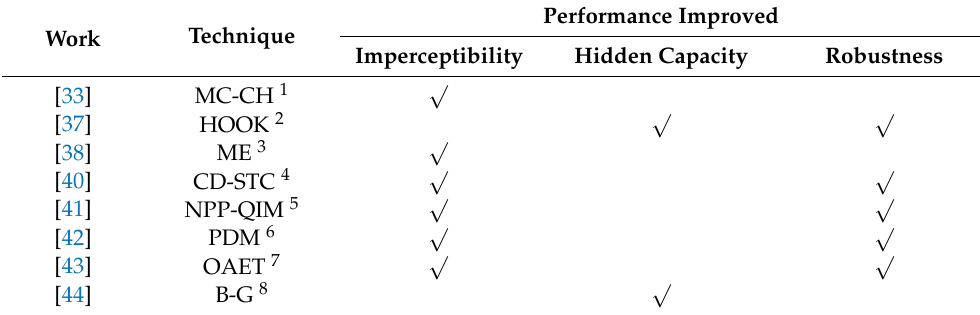
Table 5. Summary of steganography methods on